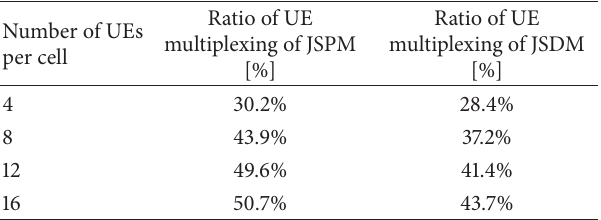
Table 3: Ratio of UE multiplexing comparison for different UE numbers per